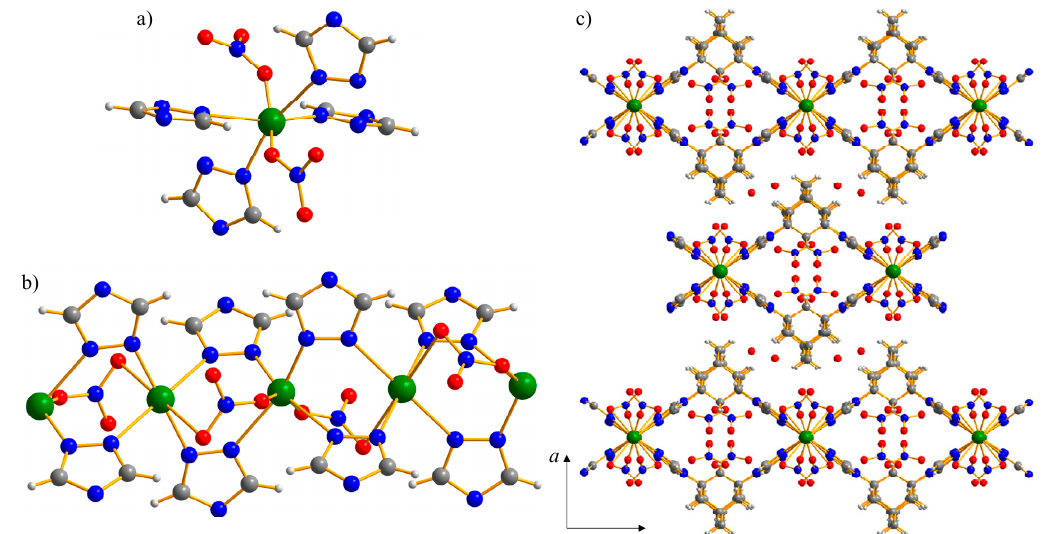
Figure 8. Representation of the crystal structure of {[Cd(tr 2 ad)(NO 3 )](NO 3 ) ∙ H 2 O} n : ( a ) the coordination sphere of the metal ions; ( b ) portion of the 1-D polymeric chains; ( c ) portion of the packing, viewed in perspective along the [001] crystallographic direction. Horizontal axis, b ; vertical axis, a . Atoms colour code: C, grey; H, light grey; Cu, green; N, blue; O, red. Main bond distances (Å) and angles (°) at the metal ions: Cd1–N 2.24(1), 2.30(1); Cd1–O 1.54(3); Cd2–N 2.17(1), 2.23(1); Cd2–O